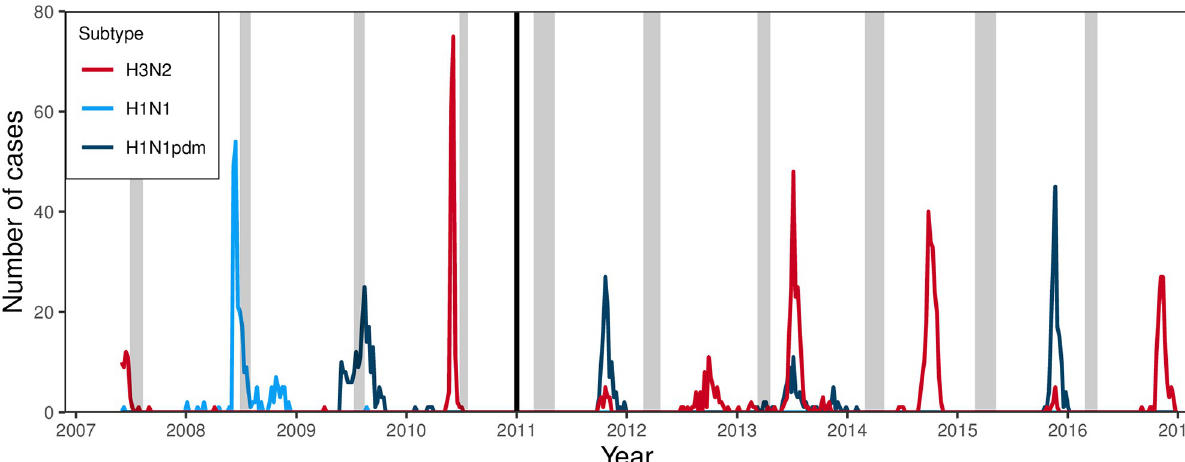
Fig 1. Incidence of influenza A by subtype in the Nicaraguan Influenza Cohort Study (NICS) and Nicaraguan Pediatric Influenza Cohort Study (NPICS). Incidence is defined as RT-PCR-confirmed cases of influenza in study participants presenting at the study health clinic with fever or influenza-like illness. In Nicaragua, influenza A circulation typically peaks mid-year (June/July) or at the end of the year (November/December). Sera samples were collected annually (July or August prior to 2011; March or April in 2011 and after). Grey bars give the period of sera sampling. Incidence before and after 2011 should not be directly compared. The cohort prior to 2011 was larger, but only a randomized subsample of eligible participants were tested, while after 2011 the cohort was smaller, but all eligible participants were tested.